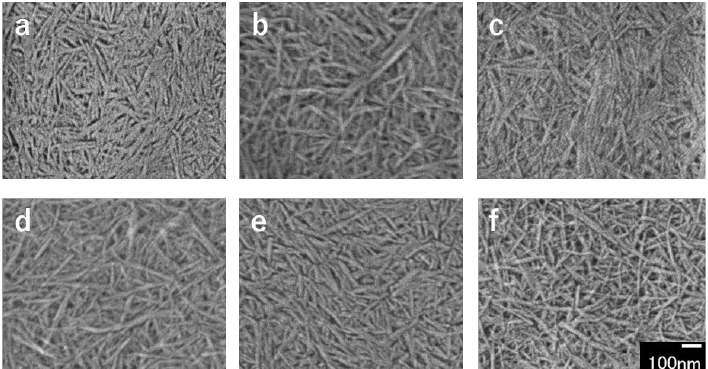
Figure 2. FE-SEM images of partially deacetylated chitin nanofibers with ultrasonication time of ( a ) 5, ( b ) 10, ( c ) 15, ( d ) 20, ( e ) 25, and ( f ) 30